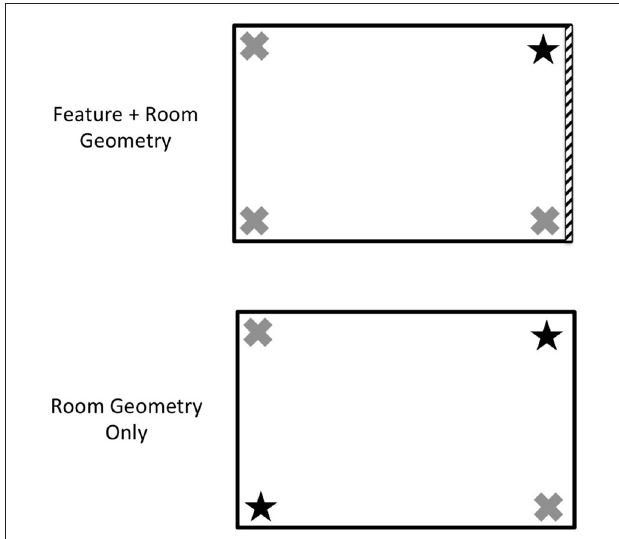
FIGURE 1 | Overhead views of typical rooms used to study reorientation . On each trial, participants first see a target object hidden in one of the four corners, are then disoriented, and finally must point to the corner with the object. In the Feature + Room Geometry condition, three walls are identical and one is unique, so that participants may encode the target object (star) using room geometry (e.g., long wall on the left, short wall on the right), the position of the object relative to the unique wall, or both. In the Room Geometry Only condition, there is no feature to disambiguate the correct corner (upper right star) from its rotational equivalent (lower left star), so these two corners are chosen about